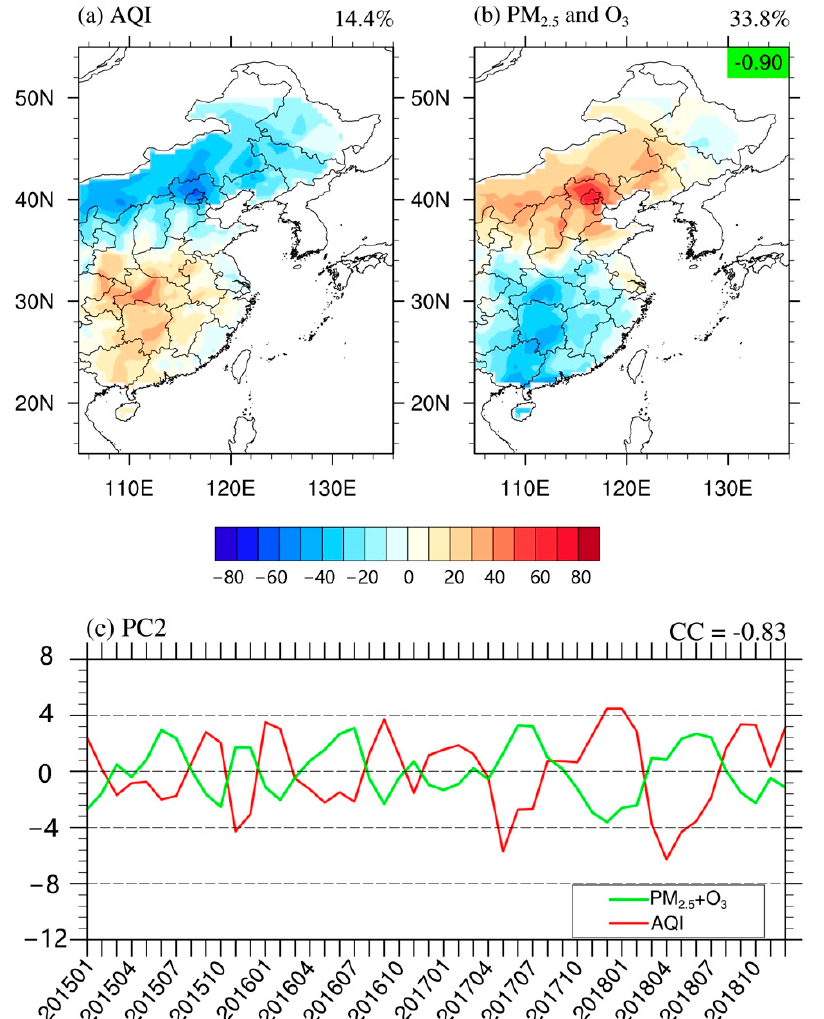
Figure 4. Comparisons of the spatial structures of the second EOF mode (EOF2) of ( a ) AQI and ( b ) ensemble mean of IAQIs of PM 2.5 and O 3 , and their corresponding principal components (PC2, ( c )). The red line indicates the PC2 for AQI, while the green line represents the PC2 for IAQI of the ensemble mean of PM 2.5 and O 3 . The fraction on the top left of panel ( a , b ) denotes the fractional explained variances. The spatial correlation coefficients between ( a ) and ( b ) are shown at the top right corner of panel ( b ). The correlation coefficient between the two PC2s is drawn on the top right of panel ( c ).